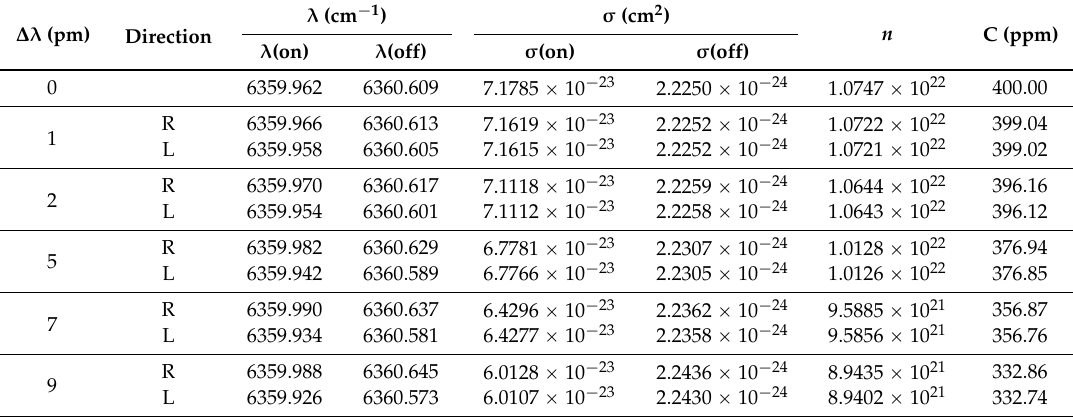
Table 3. Inversion error analysis of different shifts of wavelength in the DW-DIAL.